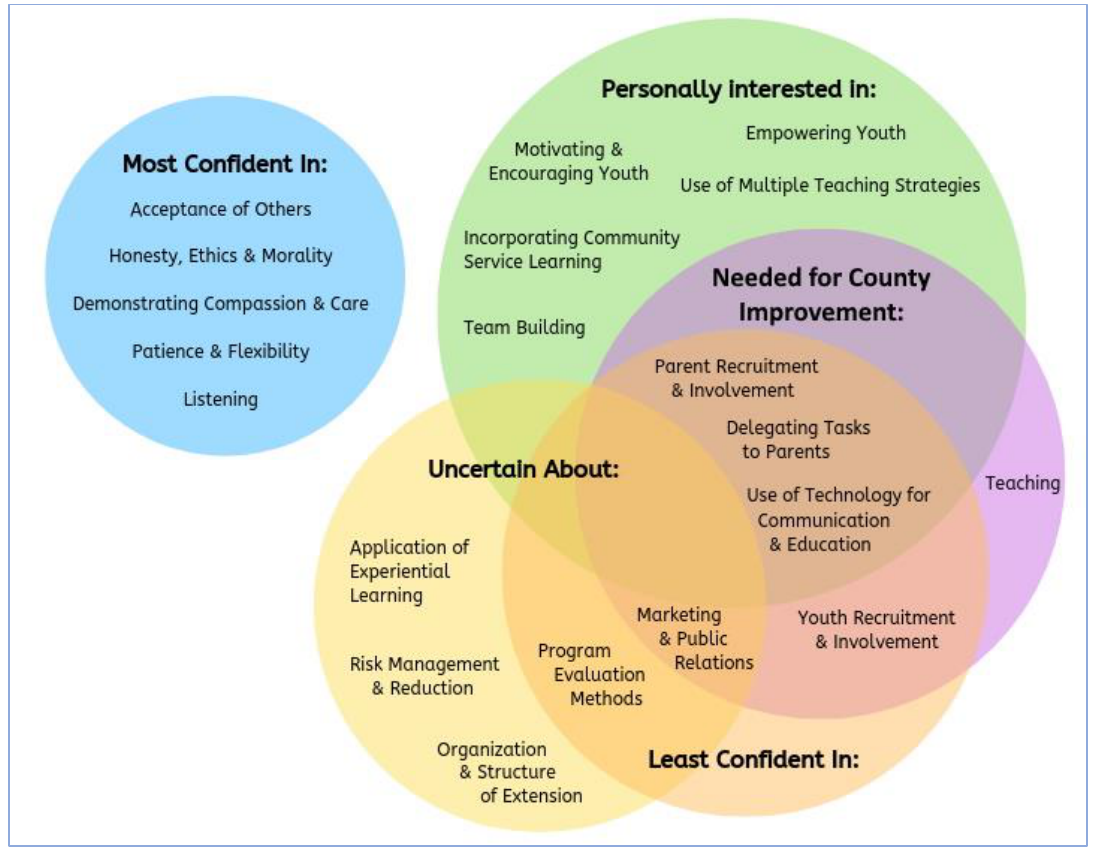
Figure 2. VRKC Self-Assessment Top-Ranking Competencies per Category